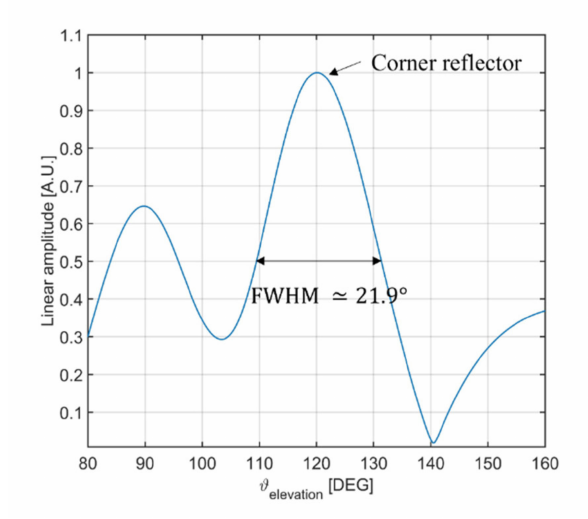
Figure 12. Point spread function in terms of elevation.